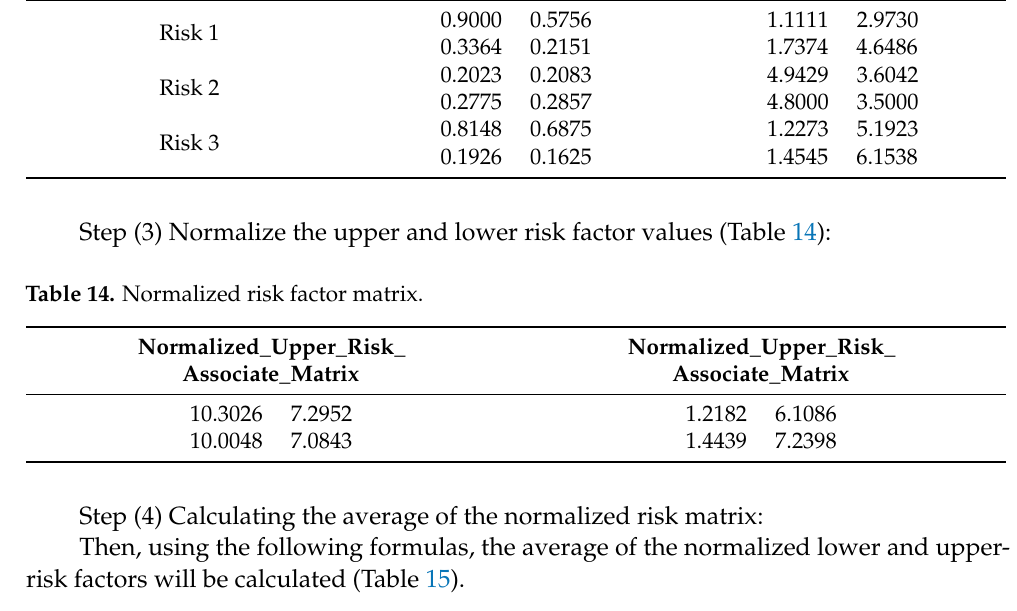
Table 15. Averaged normalized risk factor.